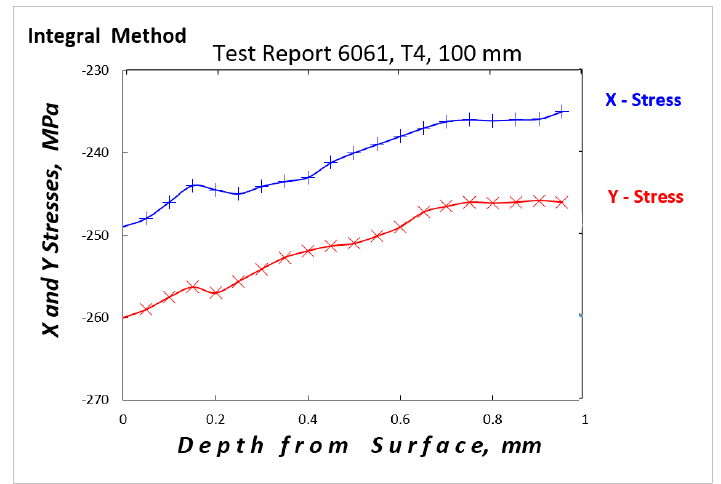
Figure 6. Non-uniform stress profile determined for 6061 aluminium plate after quenching process.